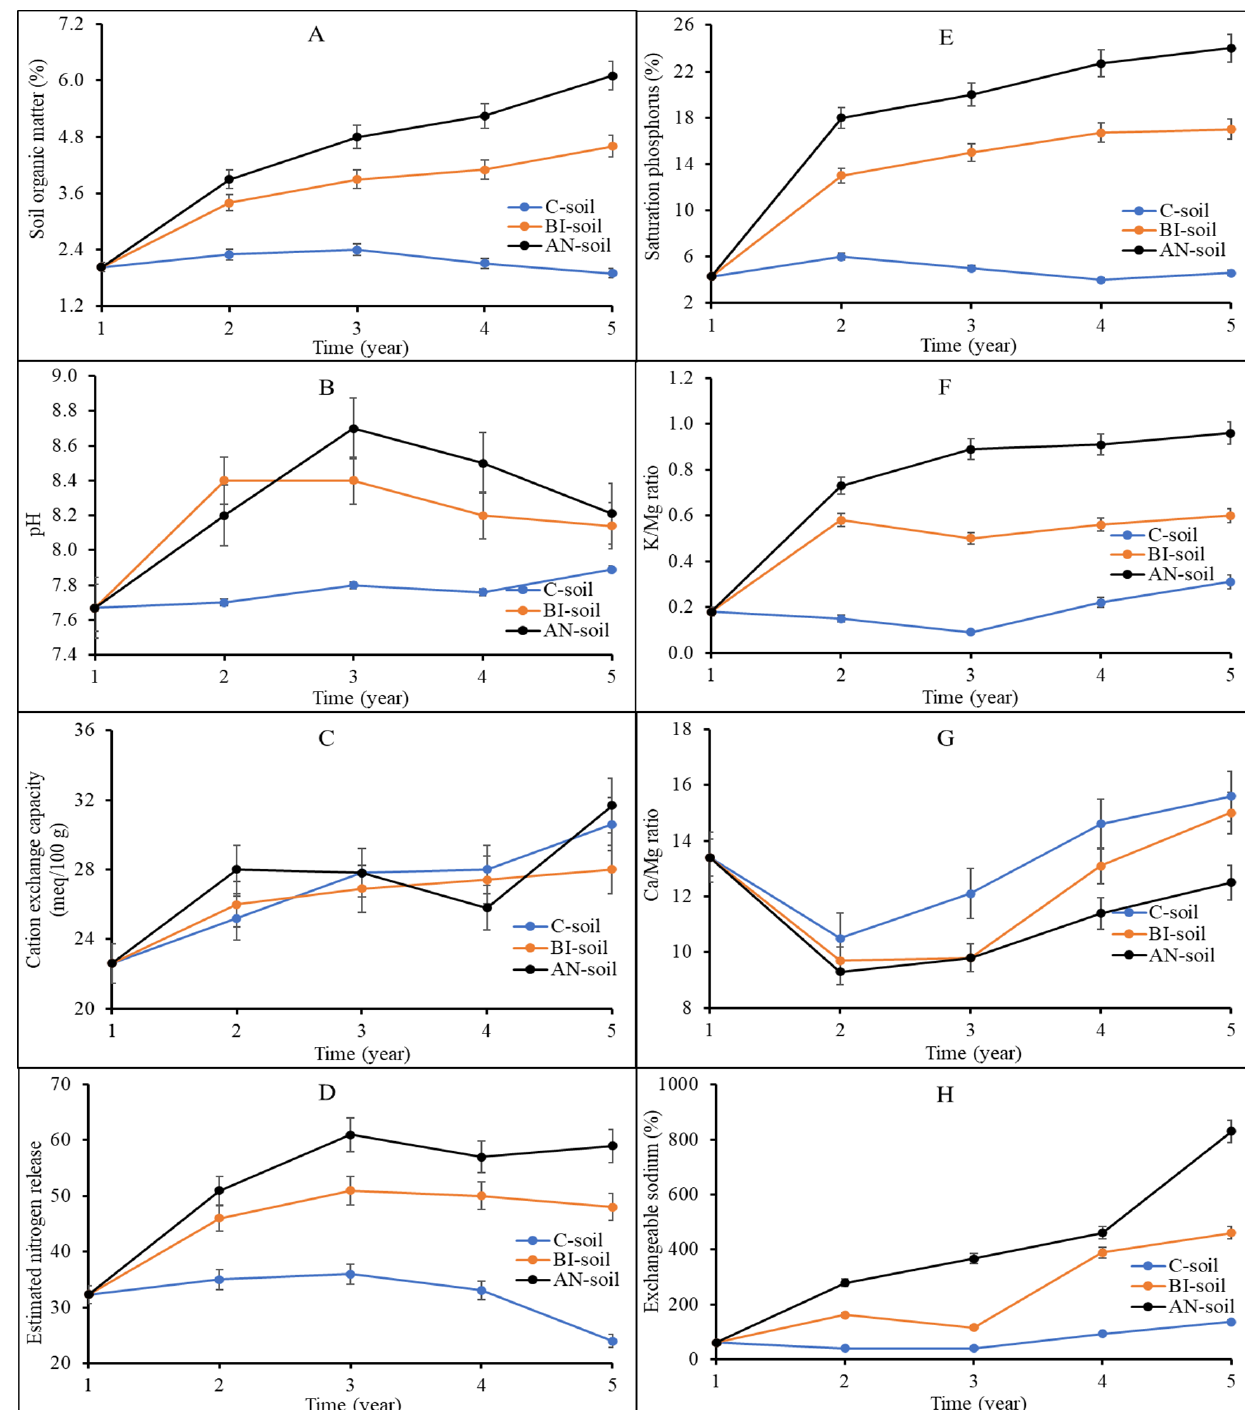
Figure 1. Changes in soil fertility status over five years of application of municipal solid waste compost at varying application frequency. C-soil, BI-soil and AN-soil represent no compost (control), biennial and annual application of compost, respectively. ( A – H ) is panel label. Vertical bars represent standard error bars (N = 9). K/Mg, potassium to magnesium ratio and Ca/Mg, calcium to magnesium ratio.